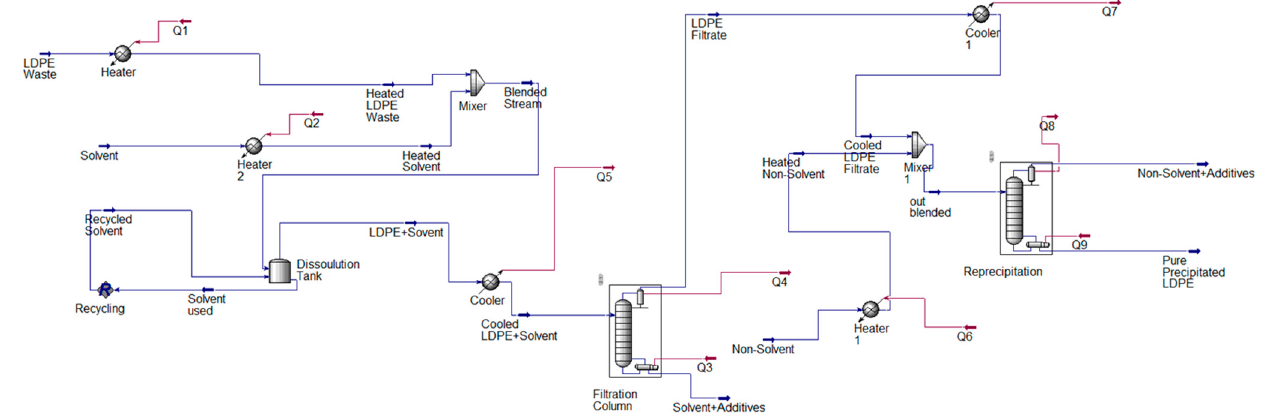
Figure 1. Dissolution/reprecipitation process flow diagram with precipitate collected at 105.4 °C.